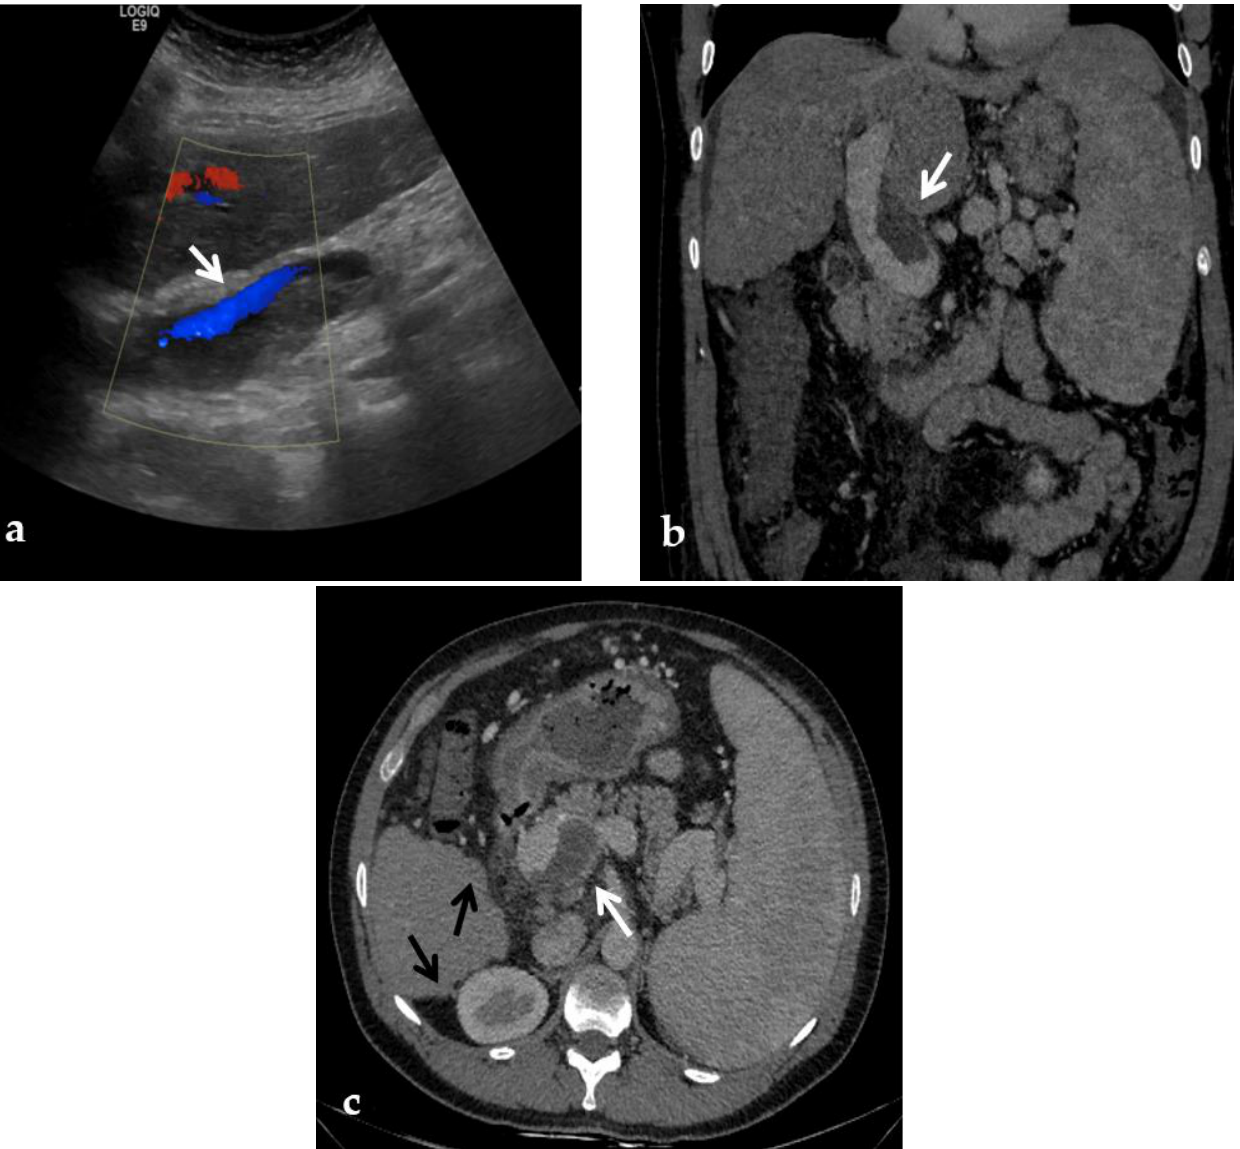
Figure 3. Color-Doppler Ultrasound and CT images of portal vein thrombosis in a 54-year-old male suffering from liver cirrhosis. ( a ) Color-Doppler Ultrasound image shows a narrow hepatopetal flow (arrow) despite a large endoluminal thrombus in the extrahepatic portal trunk. ( b ) Portal phase coronal CT image shows the lack of luminal enhancement and increased portal vein caliber due to a large endoluminal thrombus in the extrahepatic trunk (arrow). ( c ) Portal phase axial CT image shows the extension of the portal vein thrombosis up to the splenomesenteric confluence (white arrow); liver cirrhosis is visible on the the liver surface that presents lobulated margins (black ar- rows).